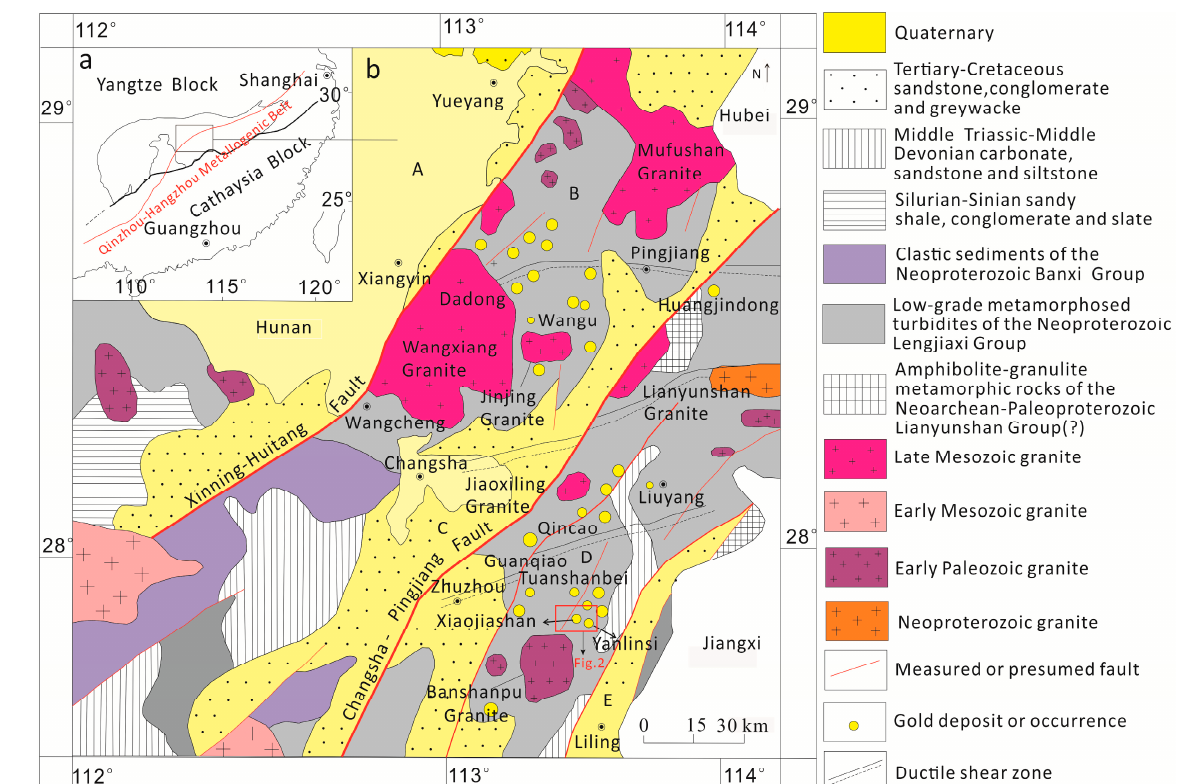
Figure 1. Geological map of the region showing distribution of gold deposits. ( a ) Simplified tectonic map of Qinzhou-Hangzhou mineralization belt. ( b ) Sketched geological map of northeastern Hunan (modified after [13]).